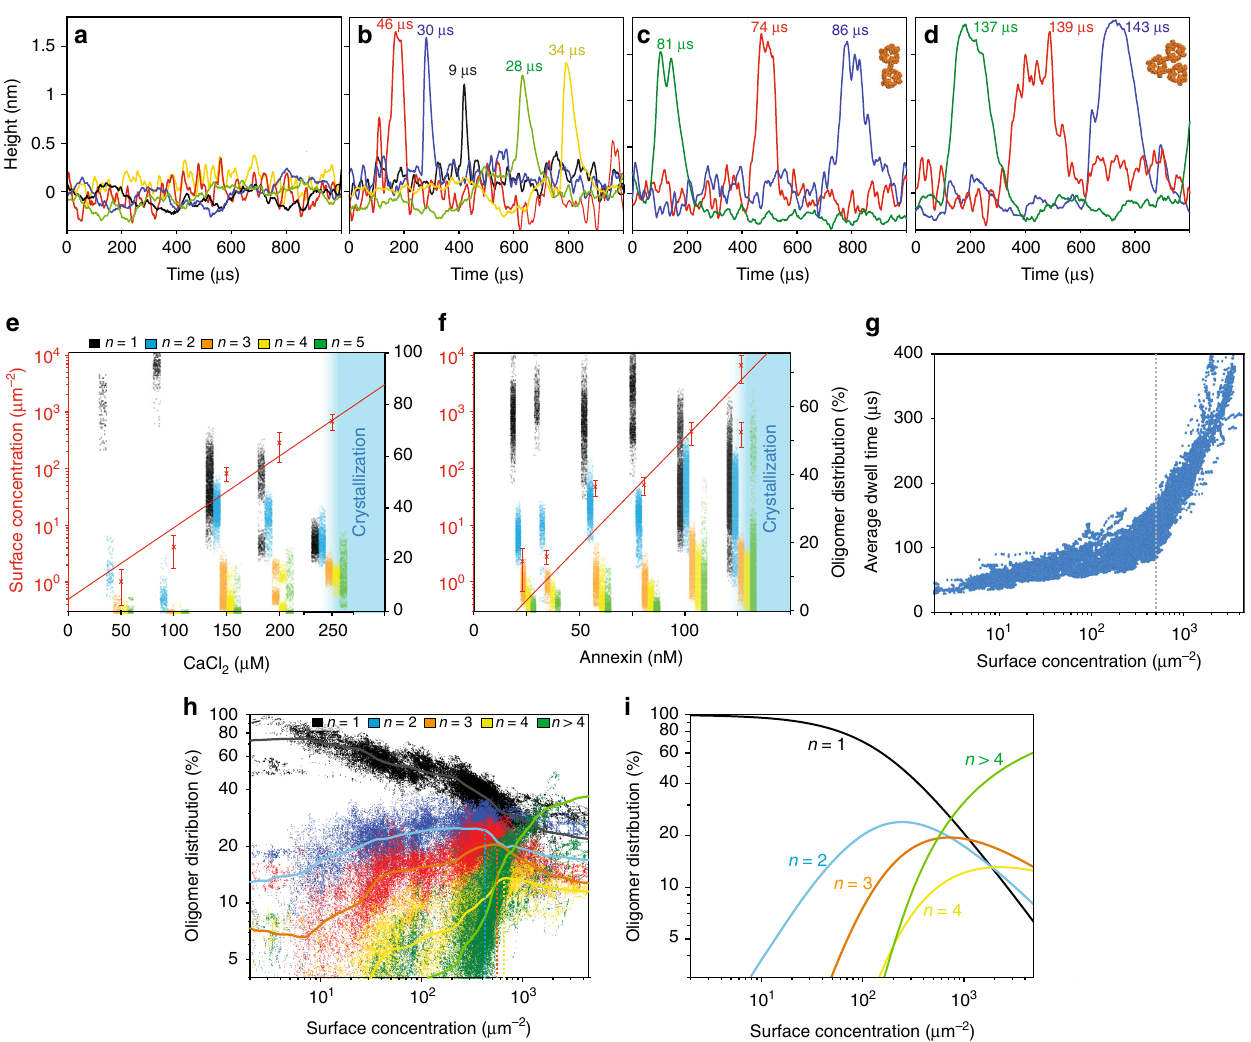
Fig. 3 Determination of A5 oligomeric states and dynamics on the membrane. a – d Overlaid 1 ms height/time traces showing background noise ( a ) and diffusion event peaks around 33 µ s ( b ), 80 µ s ( c ) and 130 µ s ( d ) dwell-times. ( e ) Averaged surface concentrations (mean±s.d.) and oligomer distributions obtained by dwell-time peak fi tting for varying Ca 2 + -concentrations at constant 127 nM annexin-V bulk concentration, and ( f ) at varying annexin-V bulk concentrations at constant 2 mM Ca 2 + concentration. Shaded areas in e and f : concentrations at which self-assembly into 2D-crystals is observed. g Graph displaying the average A5 diffusion dwell-times under the tip as a function of surface concentration. Average dwell-times are calculated from dwell-times observed within 1-second time-windows. At ~ 500 molecules µ m − 2 surface density (dashed line), the average dwell-times changes regime indicative of the formation of higher-order oligomers. h Experimental and i theoretical oligomer distributions as a function of surface concentration. Oligomer distributions in h and surface concentrations (x-axes in h and g ) are calculated over 1-second time-windows during the height spectroscopy analysis. The oligomer distributions are determined based on the range covered by the dwell-times peaks for each oligomeric state (see Fig. 2, right). Theoretical oligomer distributions were calculated using experimentally fi tted equilibrium binding constants (Table 1) between A5 and higher-order assemblies, A5 2 , A5 3 ,